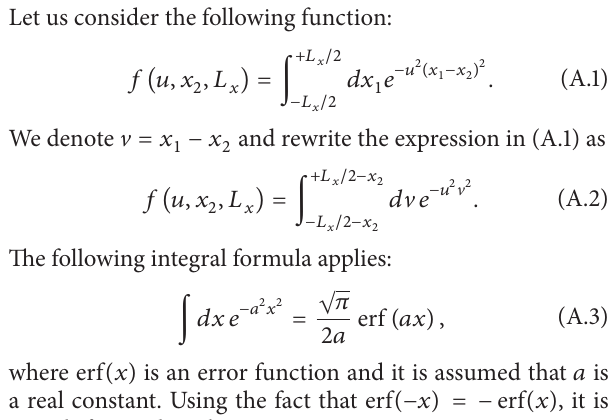
Figure 2: The Coulomb self-energy of a uniformly charged rect- angular plate, 𝑈(𝐿 𝑥 , 𝐿 𝑦 ) , can be expressed in units of 𝑘 𝑒 𝑄 2 /𝐿 𝑥 for ̸= 0 in terms of a function, 𝐹(𝛼) , where 𝛼 = 𝐿 𝐿 𝑥 nonnegative dimensionless parameter. The value 𝛼 = 1 represents a uniformly charged square. The value 𝛼 = 0 represents a uniformly charged line with length, 𝐿 𝑥 , in which a total charge, 𝑄 , is uniformly spread over its length. The values of parameter 𝛼 in the plot vary from 𝛼 = 0.01 to 𝛼 = 2 in steps of Δ𝛼 = 0.01